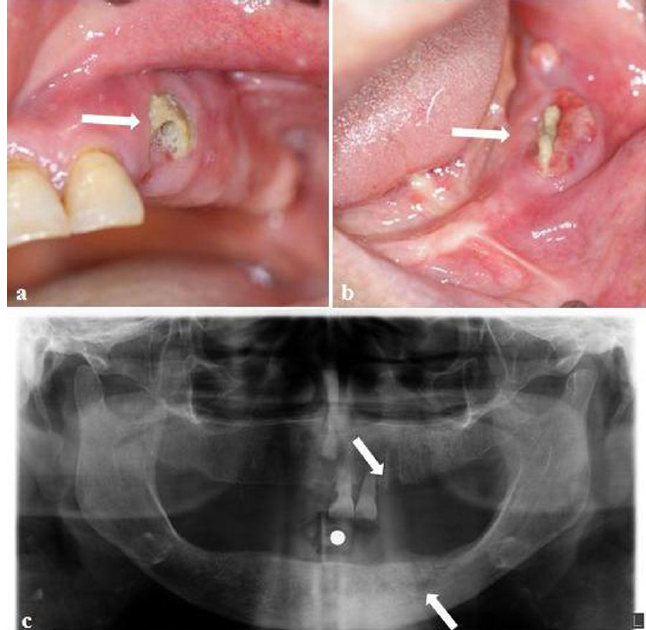
Figure 1. Clinical photographs and radiographic image from Case Report 1 . ( a,b) Clinical photograph of the non-healing extraction sites of maxillar left canine (a) and mandibular left premolar-molar area four months after their removal showing necrosis of the alveolar bone and surrounding tissue; (c) Radiographic view of the osteonecrosis around the extraction sites of teeth nos 11, 19 and 20 in a female patient with breast cancer undergoing treatment with pamidronate and